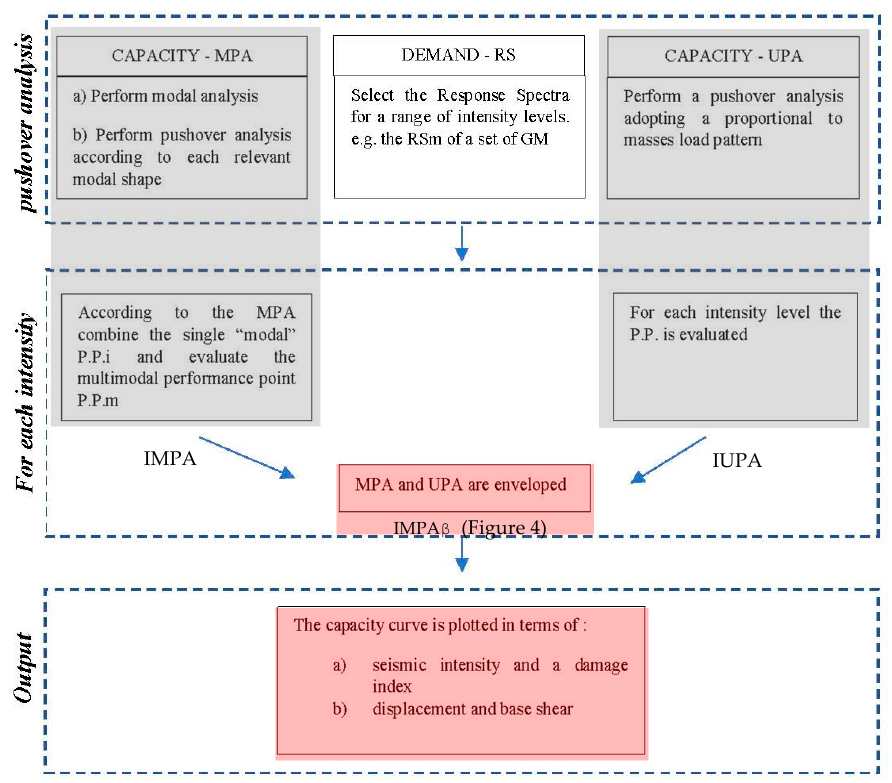
Figure 5. Flowchart of IMPA β procedure.